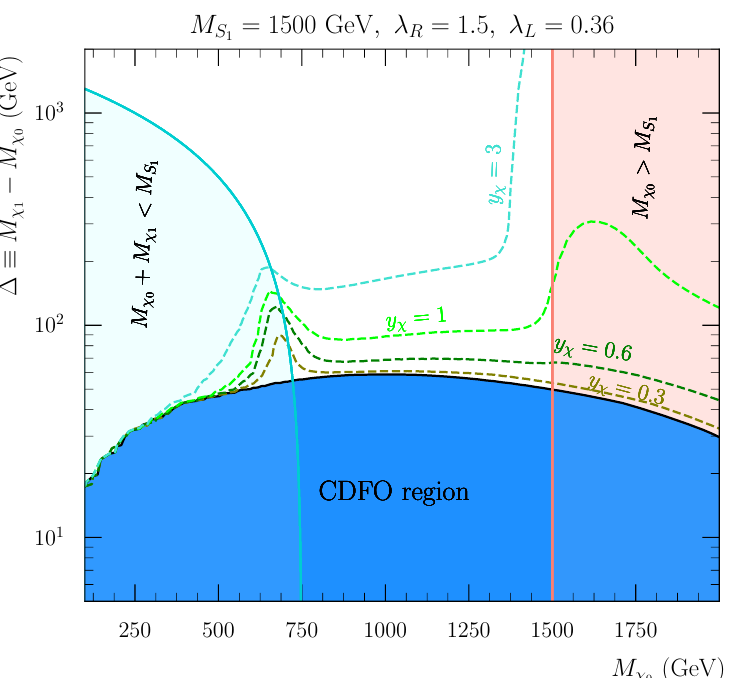
Figure 16 . Parameter space satisfying Ω h 2 = 0 . 12 for the BS2b scenario, shown in the ( M χ plane. The solid black line denotes the boundary between the standard freeze-out and conversion- driven freeze-out (CDFO) regime, and the thin dashed curves are associated with contours of constant coupling y χ = 0 . 3 (olive), 0 . 6 (green), 1 (lime) and 3 (turquoise). The turquoise shaded area corresponds to a parameter space region where the leptoquark dark decays are allowed, while in the shaded salmon area, M χ > M S 0 1